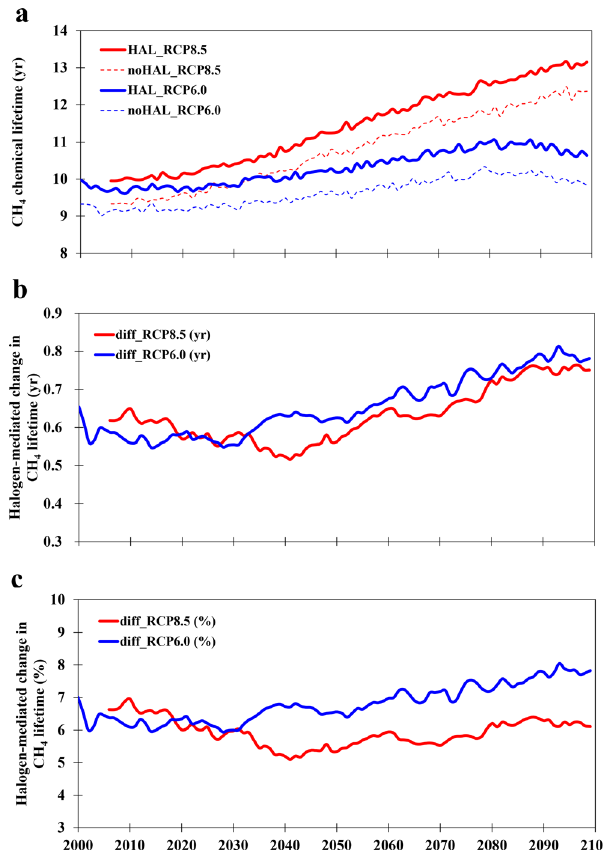
Fig. 4 Evolution of halogen-mediated change in CH 4 chemical lifetime in the 21st century for RCP6.0 (blue line) and RCP8.5 (red line) scenarios. a Global CH 4 chemical lifetime (yr) for simulations with (HAL, solid line) and without (noHAL, dashed line) halogens; b Halogen-mediated change in CH 4 lifetime in absolute term (yr); c The same as ( b ) but in percentage. Note that the halogen-mediated changes are calculated with a moving average of 10 years (approximately the lifetime of CH 4 in the atmosphere). The maximum halogen-mediated effect occurs in 2093 for RCP6.0 with an enhancement of ∼ 0.9 yr (9.4%). Note that the results for RCP8.5 are only shown from 2006 to 2100 and the results before 2006 are identical to those in RCP6.0. CH 4 lifetime with respect to tropospheric OH is shown in Supplementary Fig. The global CH 4 RF in the 21st century for all model simulations (Fig. 5d) follow the same trend as the CH 4 atmospheric burden (Fig. 5a): CH 4 RF in the RCP6.0 scenario remains at ~0.6 W/m 2 during the century while that in RCP8.5 drastically increases to ~1.5 W/m 2 by 2100. The global CH 4 RF change induced by halogens for the two RCP scenarios is similar in terms of the absolute values (W/m 2 ; Fig. 5e), but shows a comparatively larger percentage change in RCP6.0 (Fig. 5f). Halogen-induced CH 4 RF increases by 0.04 W/m 2 (8%) in the early 2000s and 0.06 W/m 2 (12% in RCP6.0 and 4.5% in RCP8.5) towards 2100, thereby enhancing global CH 4 induced warming in the 21st century. Note that the pre-industrial to present-day RF increases due to the key well-mixed GHGs are 1.95 (CO 2 ), 0.62 (CH 4 ), and 0.18 (N 2 O) W/m 2 (ref. 29 ). Thus, the halogen effect on RF via changing CH 4 abundances, currently not considered in climate models, is estimated to represent up to one-third of the historical N 2 O RF and ~10% of the CH 4 RF.